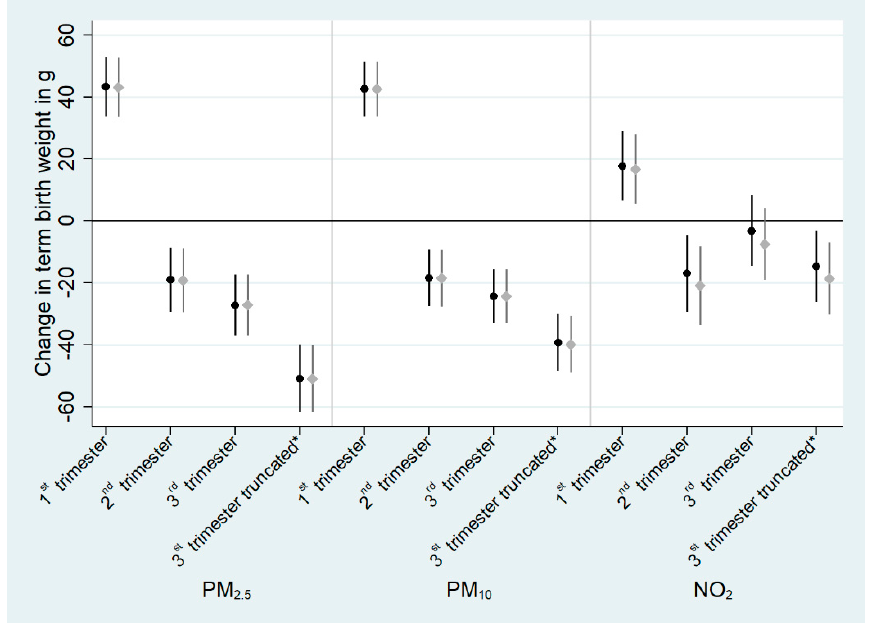
Figure 3. Adjusted difference in mean term birth weight (g) associated with atmospheric pollutant exposures during pregnancy ( n = 13,334 pregnant women from ELFE cohort) accounting for the correlation among trimesters of pregnancy. All effect estimates correspond to an increase of 5 µg/m 3 for PM 2.5 and PM 10 and 10 µg/m 3 for NO 2 . Regression coefficients are from weighted doubly robust generalized additive models 1 . Estimates corresponding to models with full weights (in black) and trimmed weights (in grey) are represented. The point shows the central estimate, the line represents the 95% confidence interval. 1 using the stabilized inverse probability of being exposed to air pollutants calculated using maternal education, in relationship status, parity, sex of the child, maternal active smoking during pregnancy, social deprivation, maternal French citizenship, maternal age, weight before pregnancy and maternal height, and further adjusted for the aforementioned covariates plus urbanization level, season of conception and residuals of the regression between trimesters. * exposure truncated at 37 gestational weeks. Table 3. Associations between atmospheric pollutant exposure during pregnancy and term birth weight, stratified according to the urbanization level. All effect estimates are reported for an increase by 5 µ g/m 3 for PM 2.5 and PM 10 and by 10 µ g/m 3 for NO 2 . Regression coefficients are estimated from weighted doubly robust generalized additive models 1 trimmed at the 1st and 99th percentiles ( n = 13,334 pregnant women from ELFE cohort).